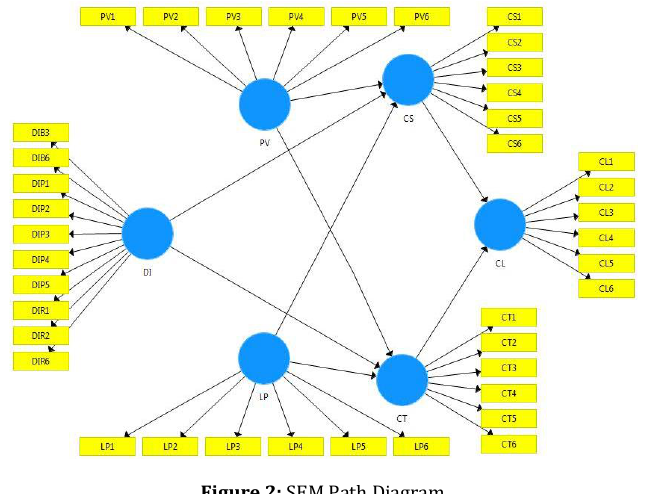
Figure 2: SEM Path Diagram